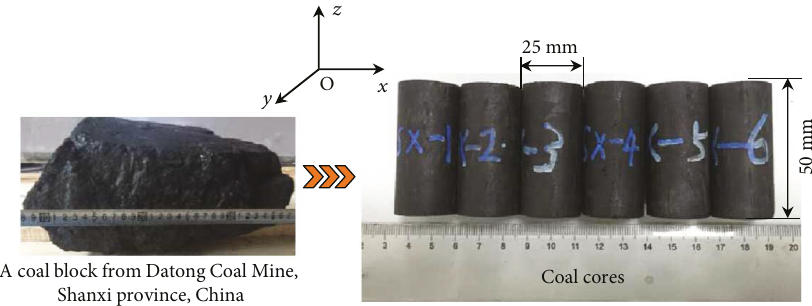
Figure 2: Images of coal block and drilled cores.